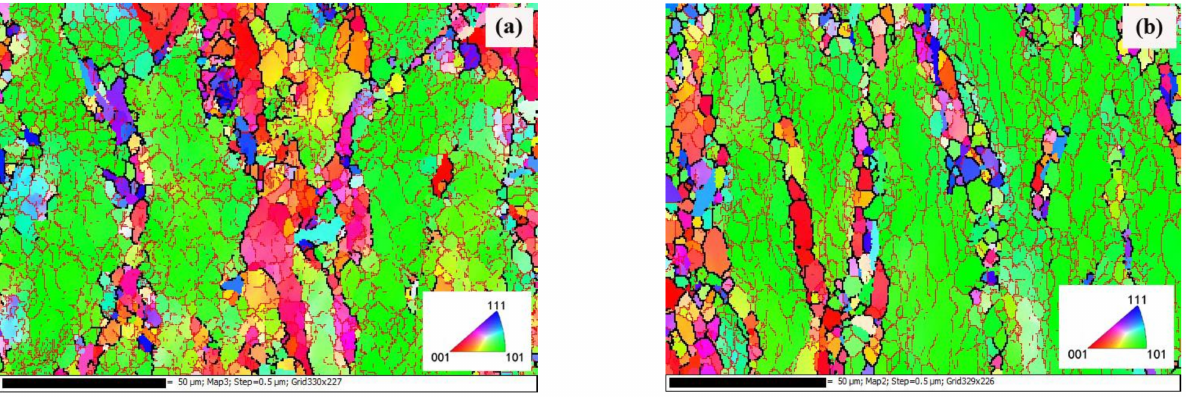
Figure 2. The EBSD maps of A356 under different loading parameters: ( a ) T = 400 ◦ C, 0.1 s − 1 , ε = 0.6; ( b ) T = 400 ◦ C, 0.1 s − 1 , ε =